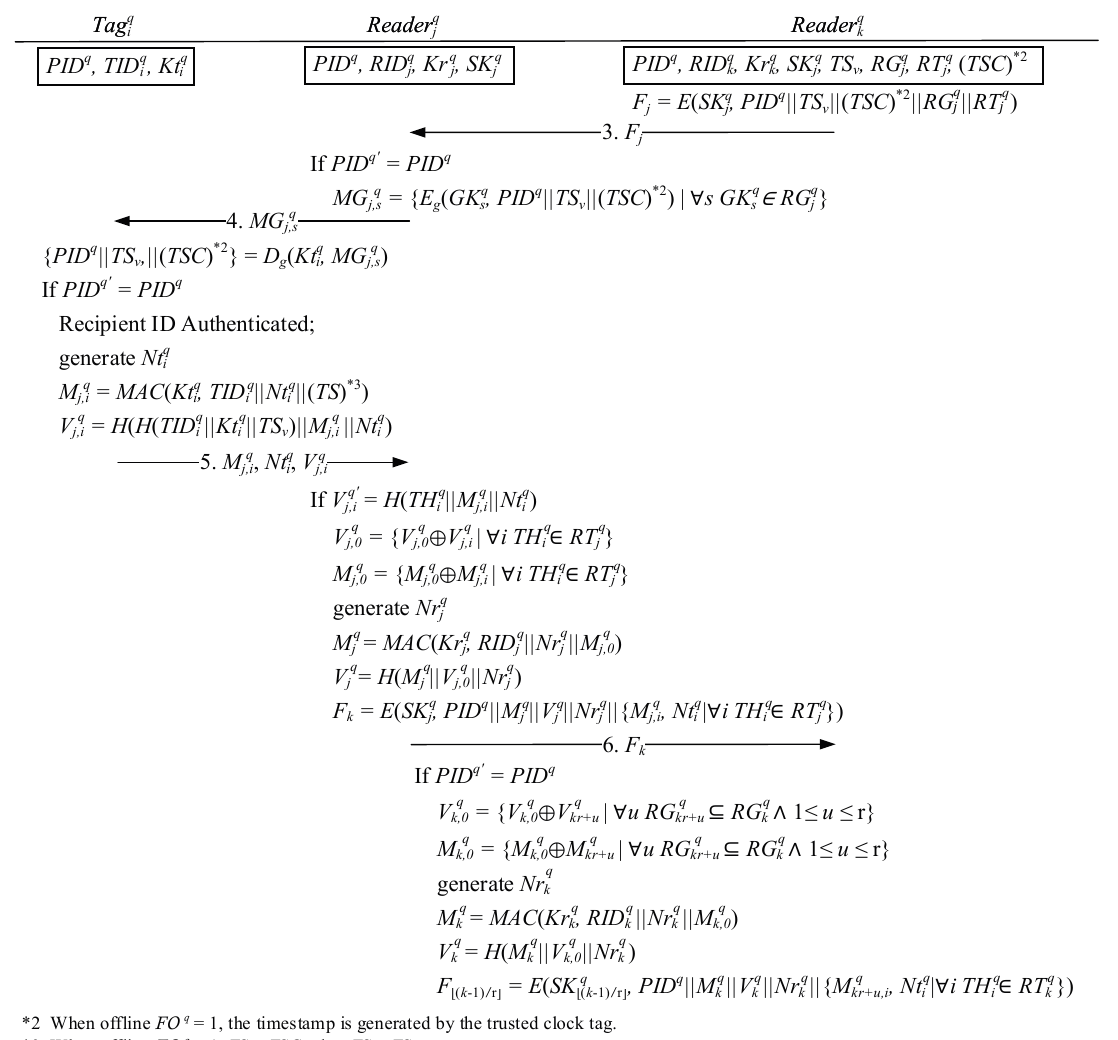
Figure 6. Generating grouping proofs by multilayered